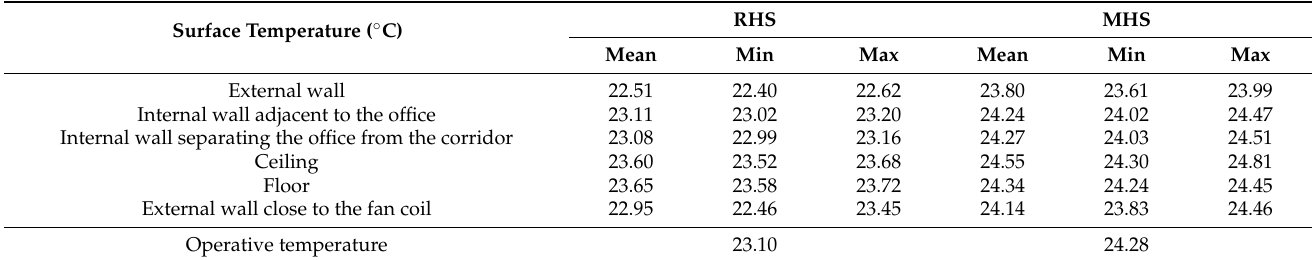
Figure 9. Outdoor air temperature and relative humidity fluctuations for MHS [32]. Table 5. Results of all monitored surface temperature measurements of the meeting room for RHS and